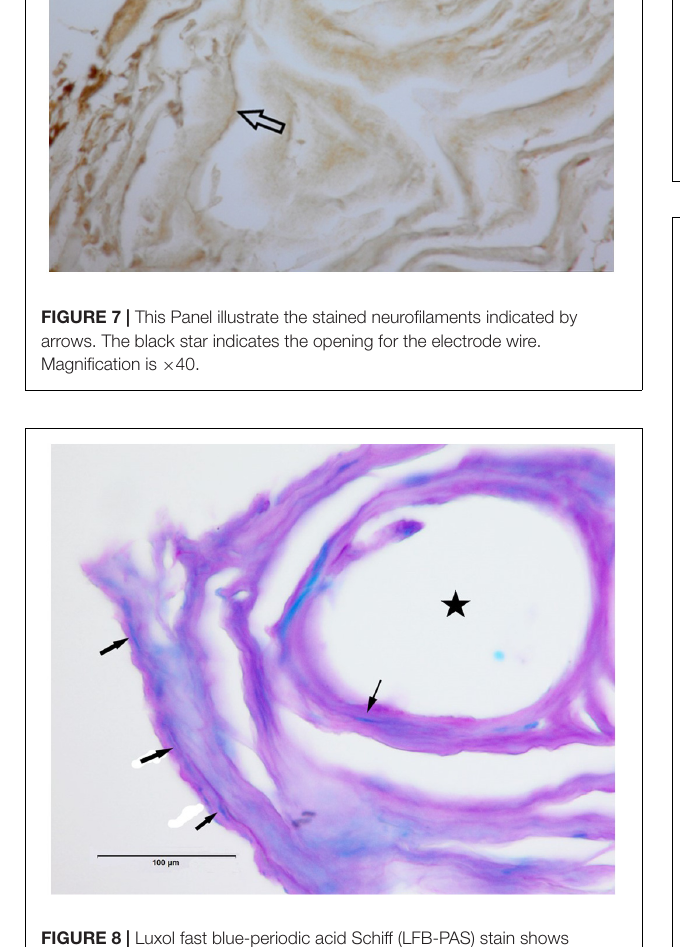
FIGURE 8 | Luxol fast blue-periodic acid Schiff (LFB-PAS) stain shows examples of myelinated axons in blue (arrows). Star indicates hole in tissue where once the electrode wire resided.